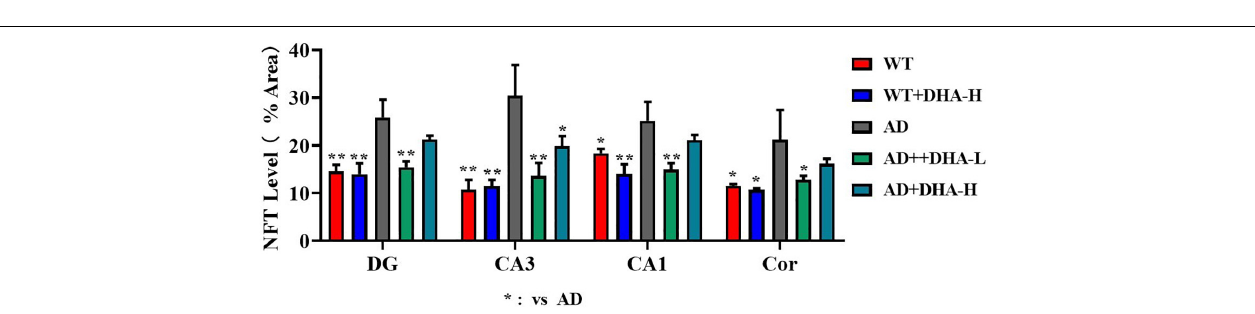
FIGURE 9 | Effects of DHA treatment on common small molecules in the brain in 2 × Tg AD mice. (A) Myo-Inositol, (B) glycine, (C) taurine. Student’s t test was used for statistical analyses. Error bars represent mean ± S.E.M. ( n = 4). * P < 0.05.